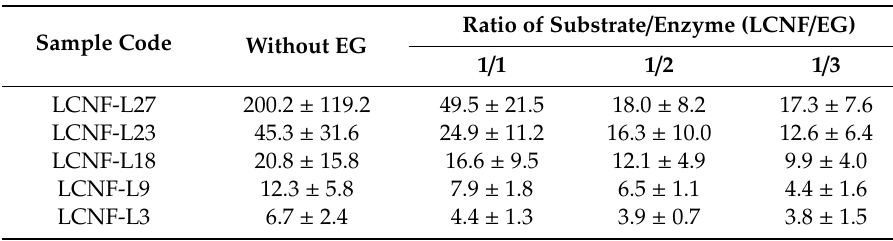
Table 3. Average diameter and standard deviations of LCNFs with di ff erent lignin contents after enzymatic treatment using di ff erent EG contents (units: nm).